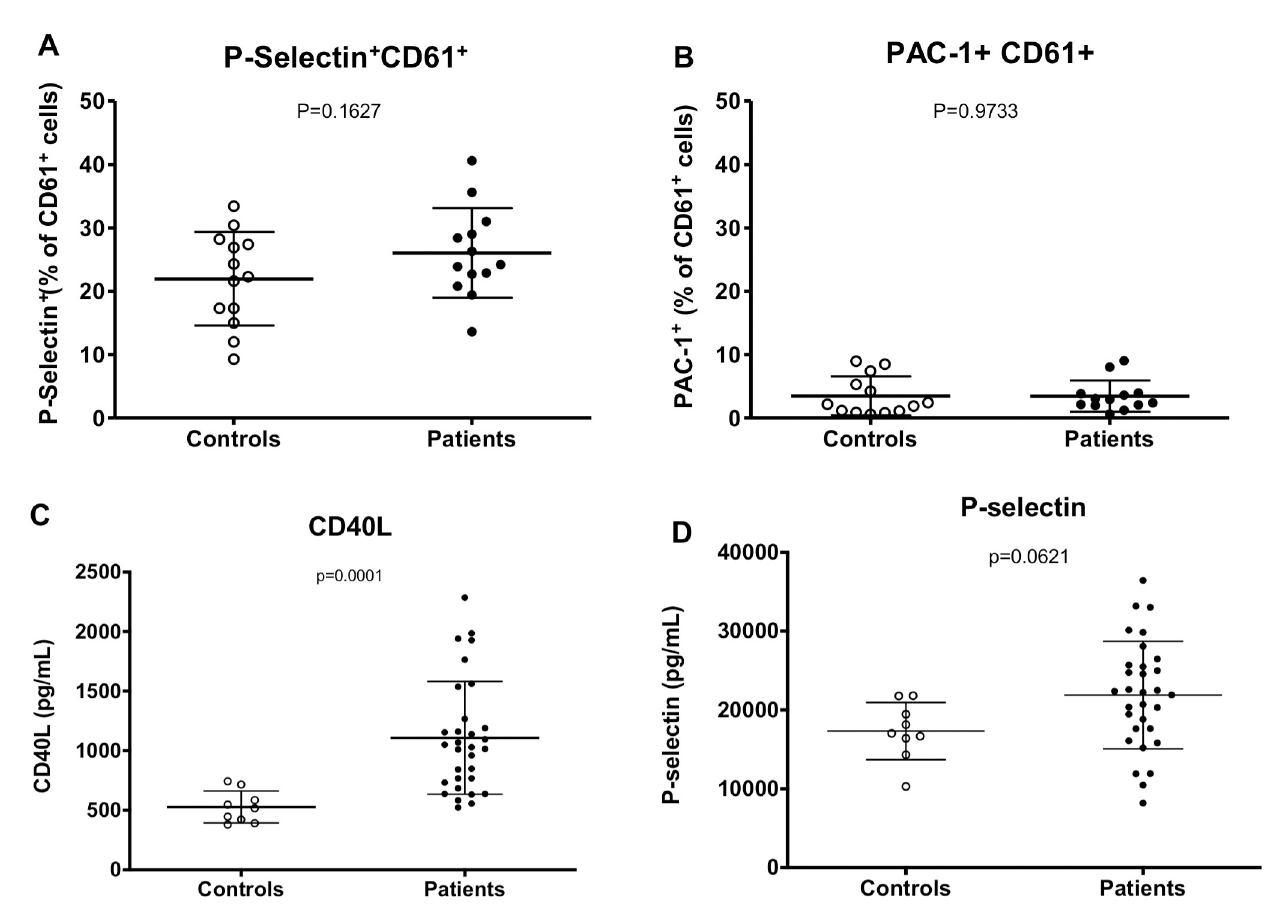
Fig 2. Platelet activation. Percentage of platelet activation by A) anti-P-selectin (N = 14) and B) PAC-1 staining (N = 11). C) Levels of sCD40L. D) Levels of sP- selectin. (Controls, n = 9, Patients n = 31).